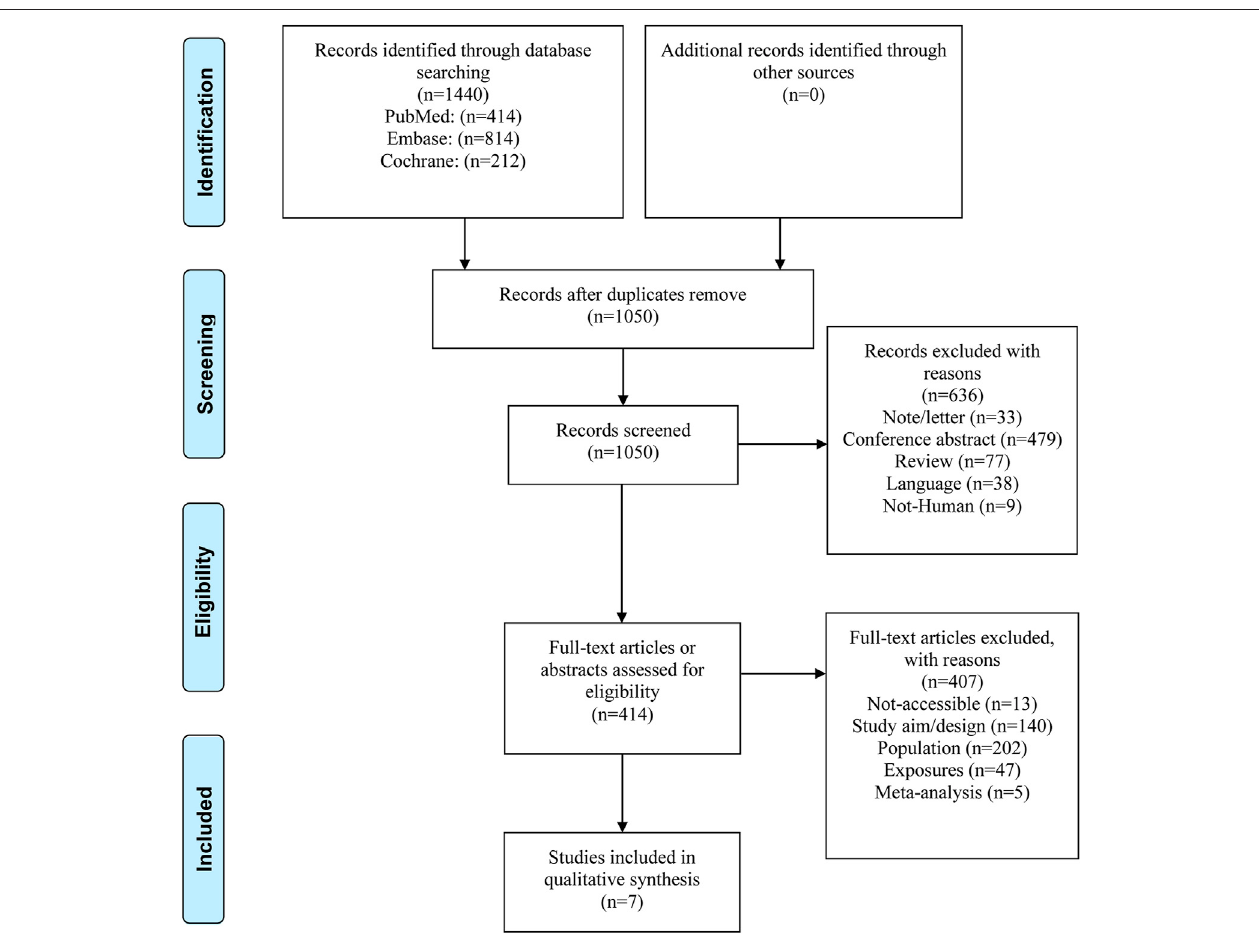
FIGURE 1 | PRISMA 2009 Flow Diagram.